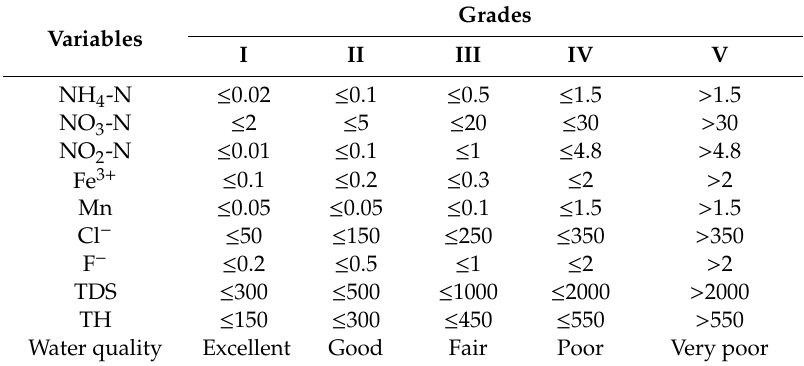
Table 1. Classification of quality of groundwater according to national Chinese standard [39]. Grades Variables I II III > 1.5 NO 3 -N ≤ 2